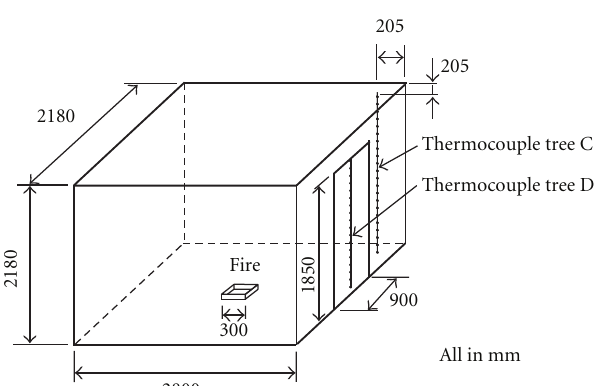
Figure 5: Air temperature of Case 2.